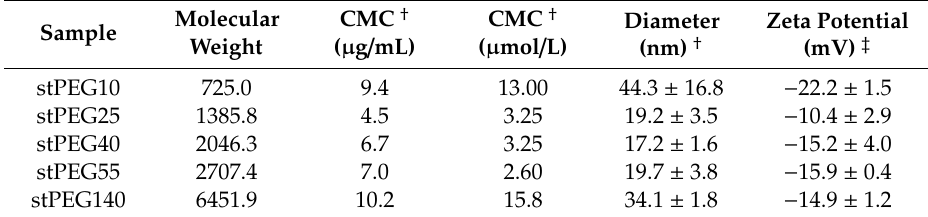
Table 2. Properties of the stPEG/CoQ10 micelles.